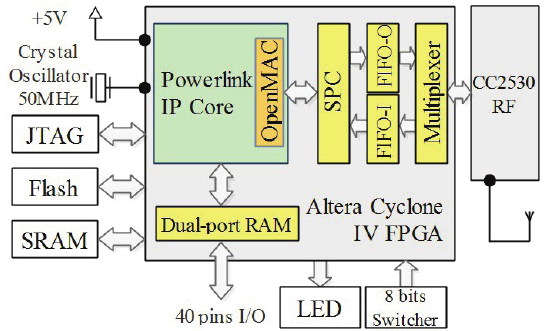
Fig. 3. FPGA-based Wireless EPL Hardware